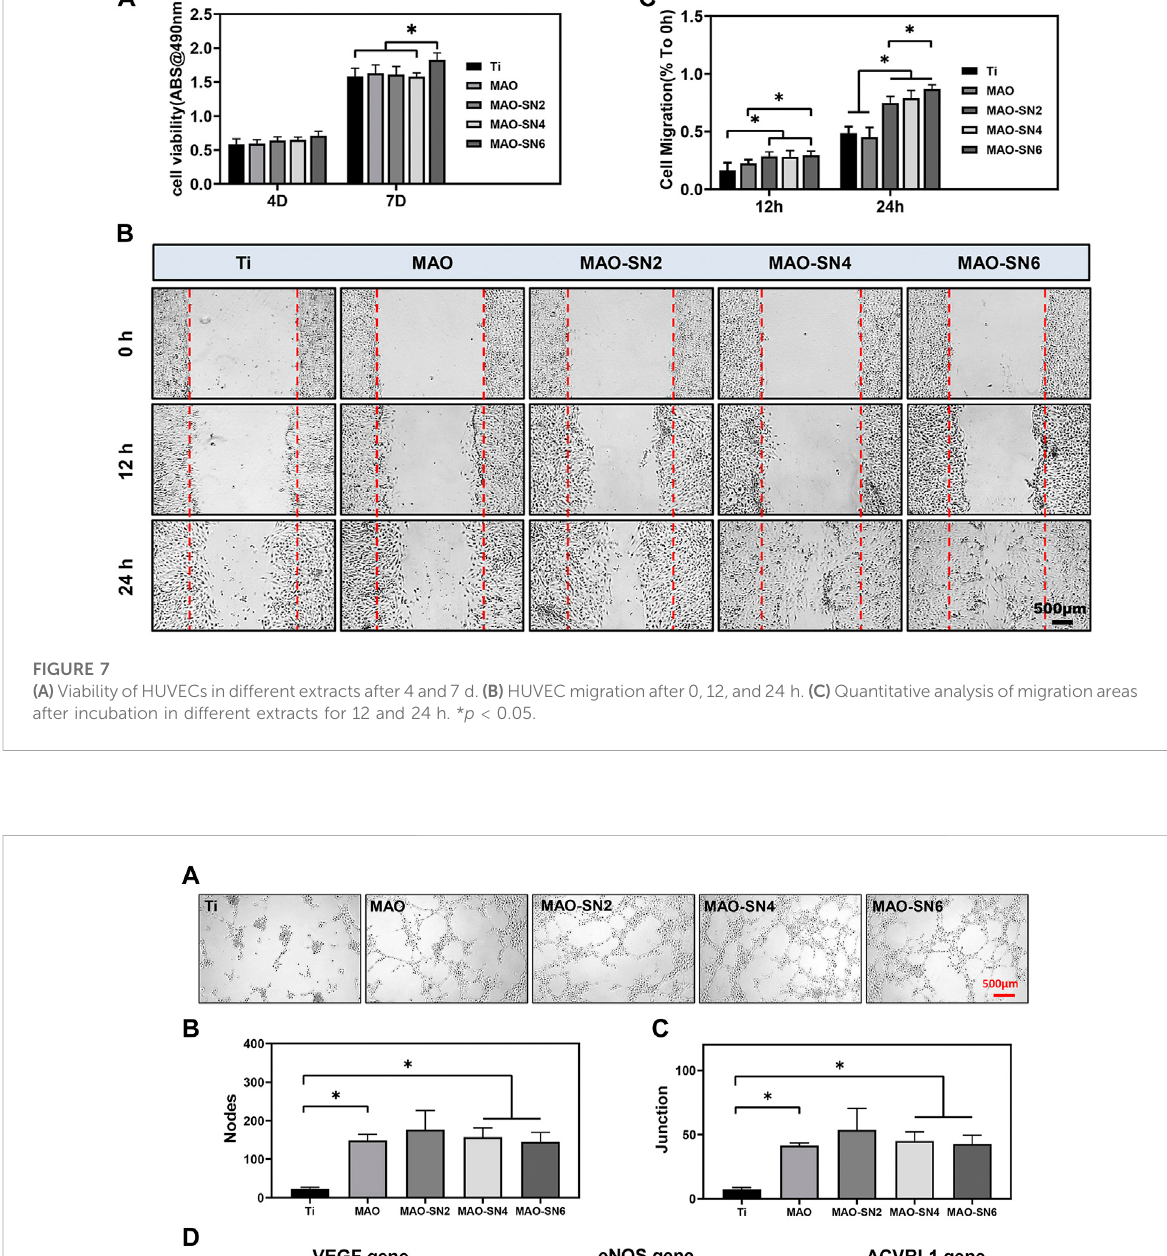
Frontiers in Bioengineering and